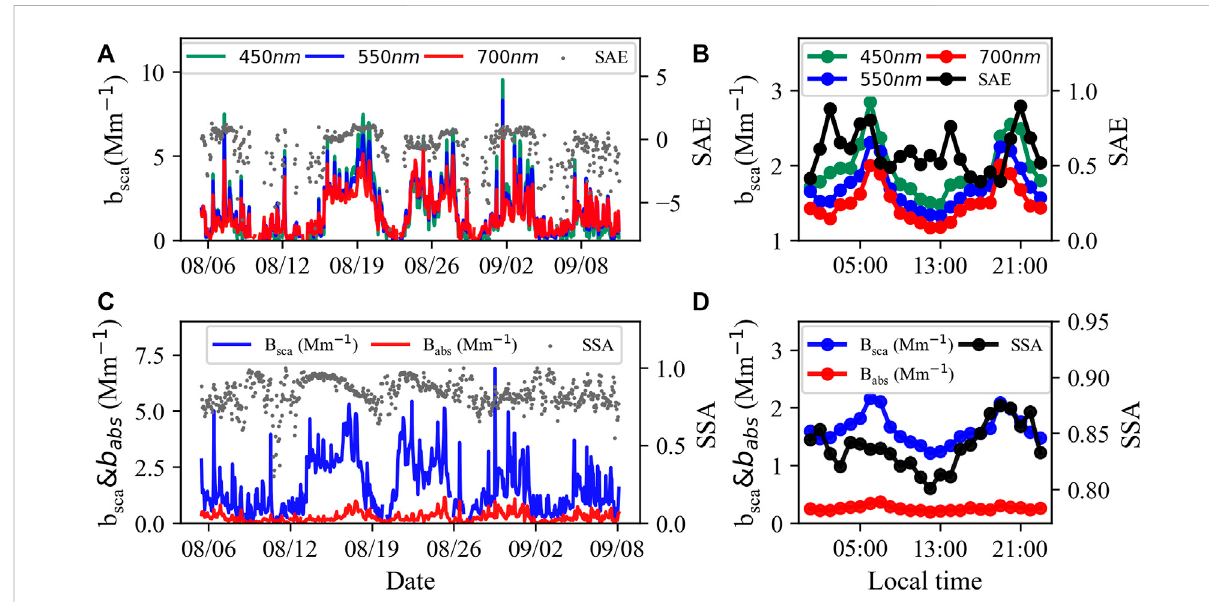
Time series of aerosol scattering coef fi cient and SAE at 450, 550 and 700 nm (A) and diurnal variation (B) time series of aerosol scattering coef fi cient, absorption coef fi cient and SSA at 670 nm (C) and diurnal variation (D)